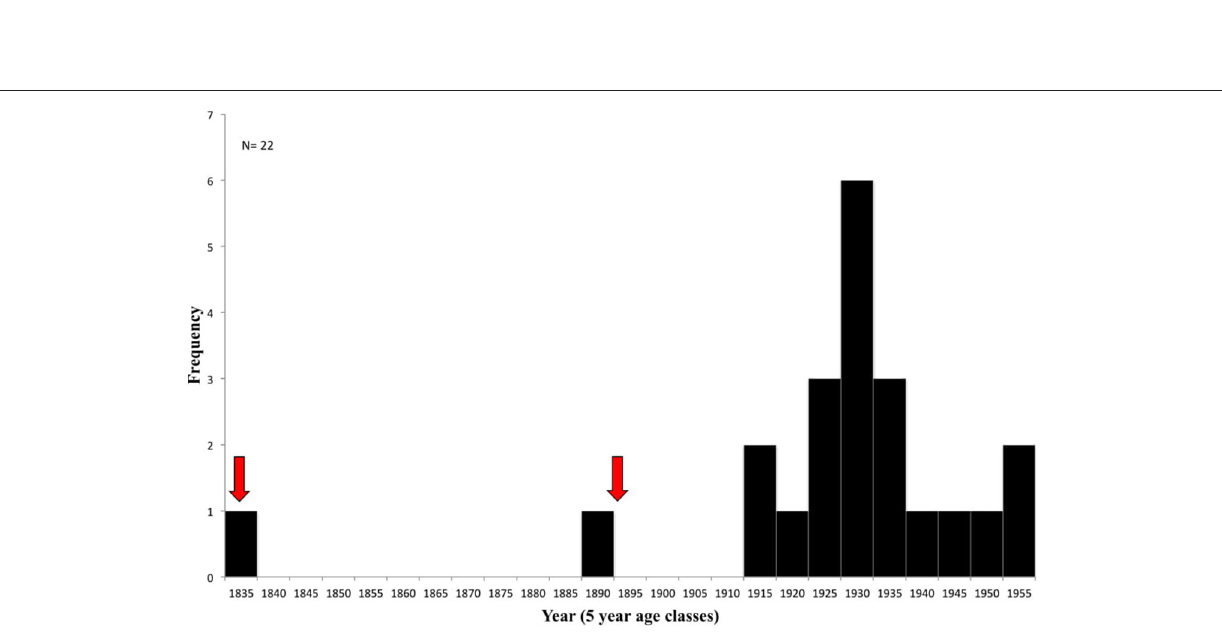
Frontiers in Ecology and Evolution |